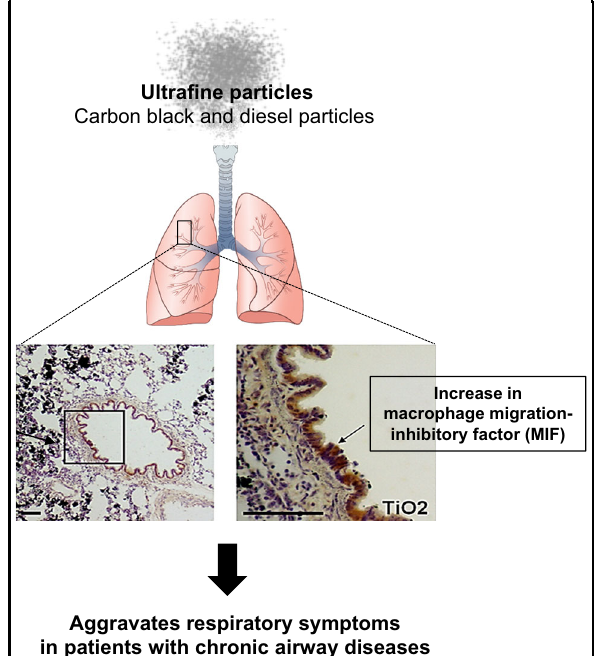
Fig. 3 PM exposure initiates innate immunity through macrophage migration inhibitory factors, leading to exacerbation of respiratory symptoms.